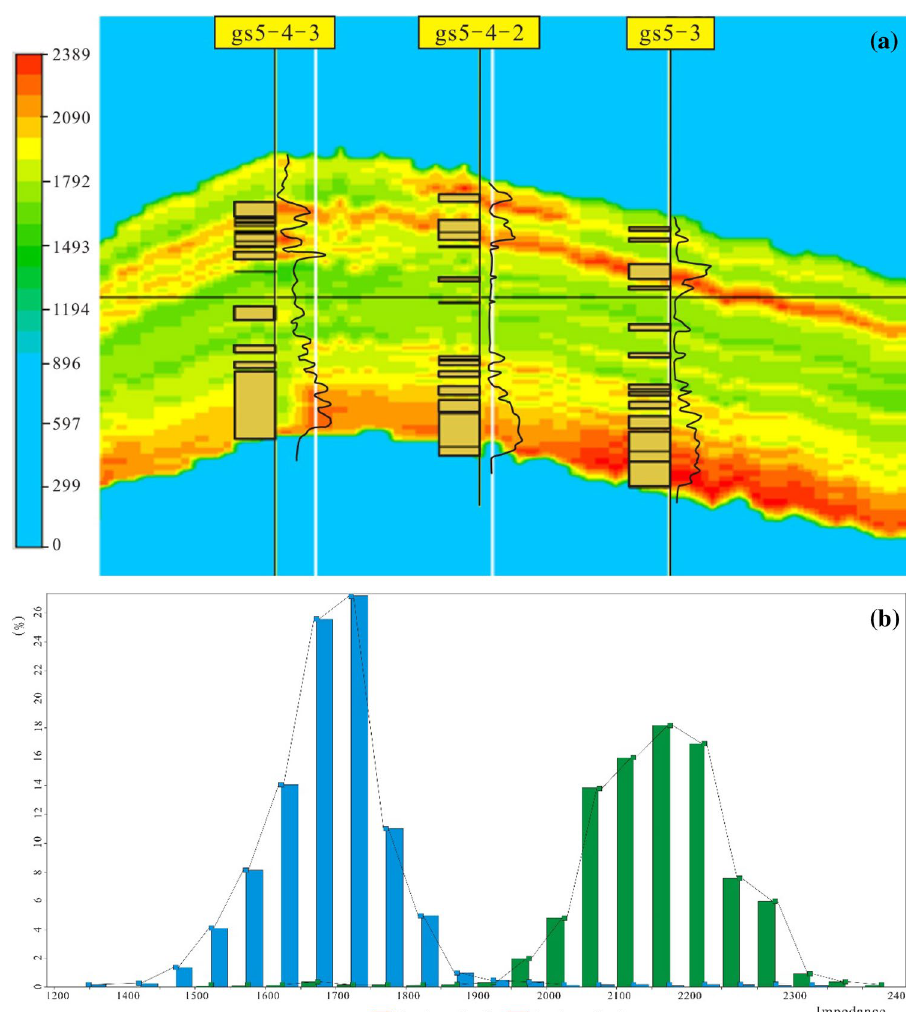
Fig. 3 Relationship of imped- ance between wells and seismic data. a Vertical section of seis- mic impedance in Well gs5-4-3, gs5-4-2 and gs5-3. b Seismic impedance histogram of sand and mud from 52